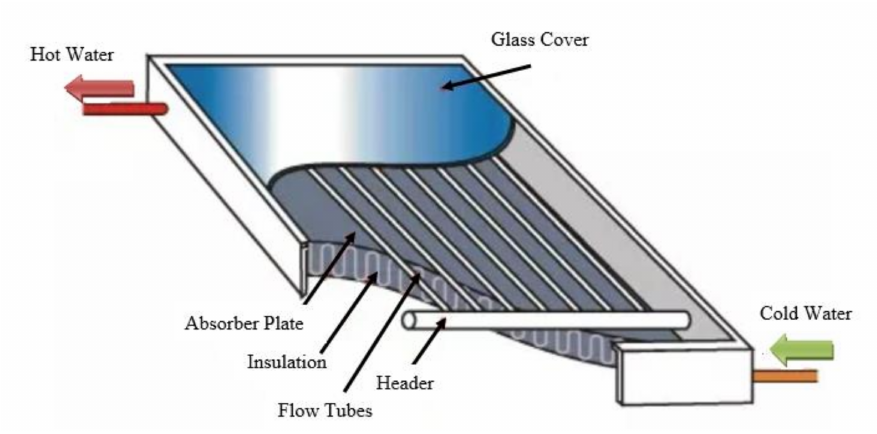
Figure 3. Typical FPSC